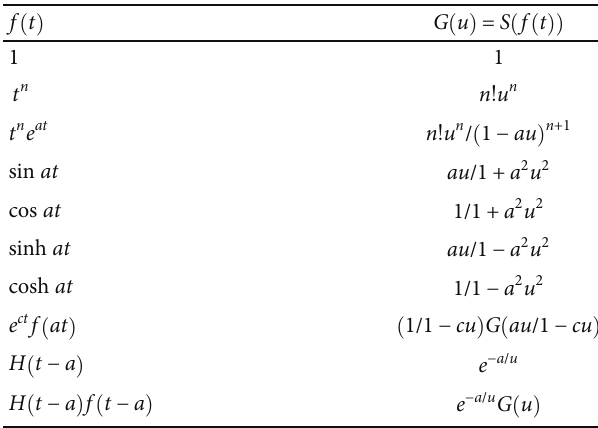
Table 2: Standard Sumudu transform for some special functions